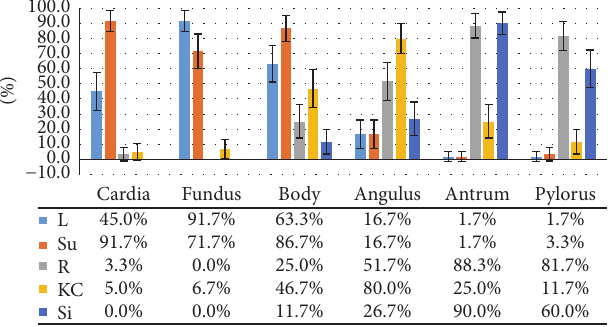
Figure 4: Comparison of gastric mucosal visualization rates from single positions. L: left lateral; Su: supine; R: right lateral; KC: knee-chest; Si: sitting.